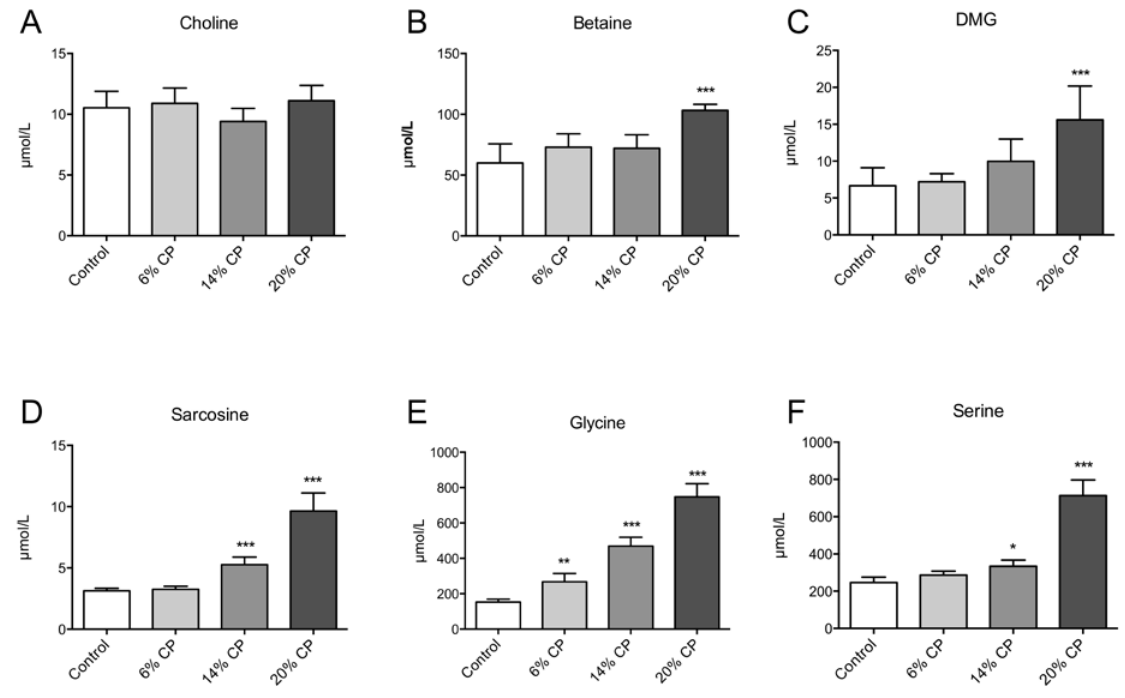
Figure 3. Plasma concentration of metabolites of the choline oxidation pathway. Rats were fed a 20% (w/w) casein control diet, or a diet containing 6%, 14% or 20% chicken protein (CP) for 4 weeks. Choline ( A ), betaine ( B ), dimethylglycine (DMG, C ), sarcosine ( D ), glycine ( E ), and serine ( F ), were measured in fasting plasma samples. Values shown are means ± standard deviation ( n = 6). One-way ANOVA with Dunnet’s post hoc test was used to determine values significantly different from control (* p < 0.05, ** p < 0.01, *** p <